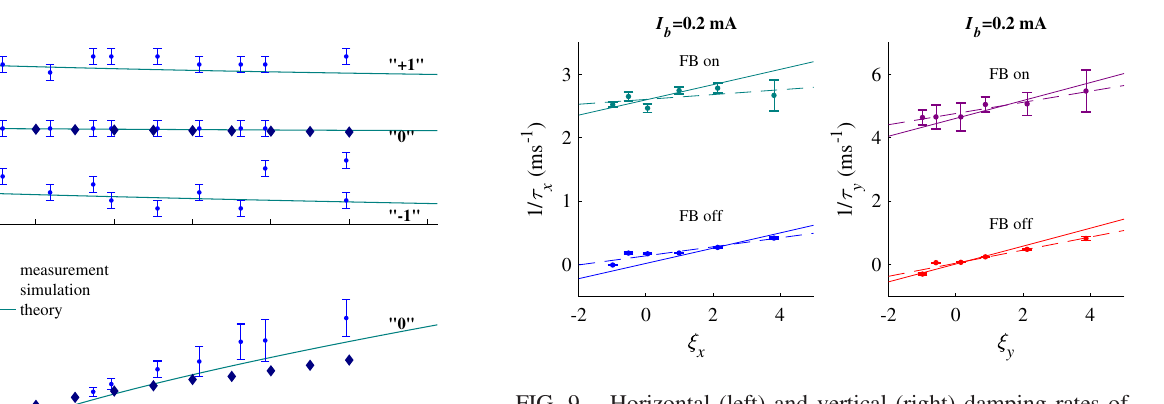
FIG. 9. Horizontal (left) and vertical (right) damping rates of the center-of-mass mode: measured data (dots with error bars), linear fit of the measured data (dashed lines), and the theoretical values (solid FIG. 7. Frequencies (top) and damping/growth rates (bottom) ¼ 2 . 1 ; feedback on. of horizontal head-tail modes; ξ x